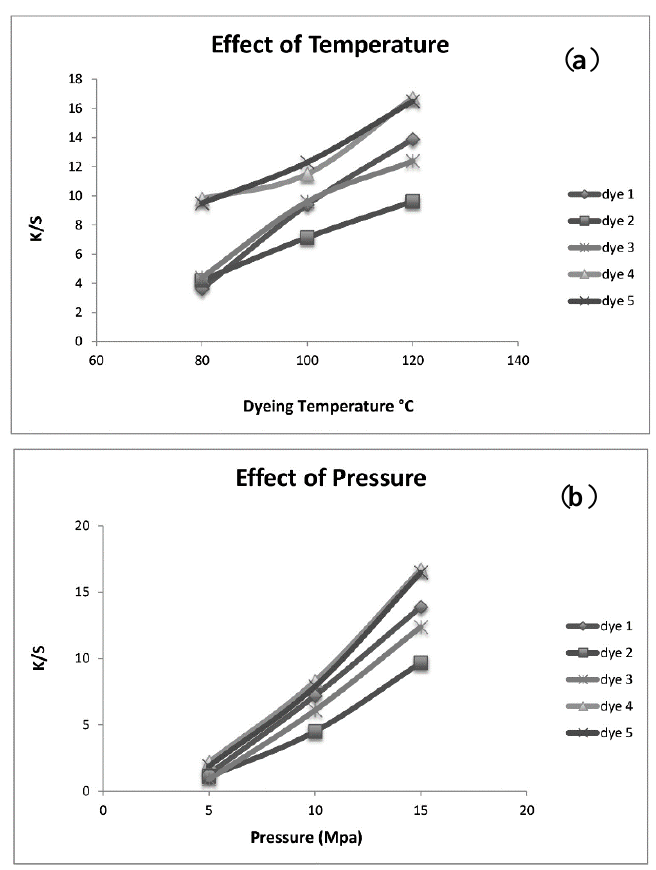
Figure 6. ( a ) Effect of dyeing temperature; ( b ) Effect of dyeing